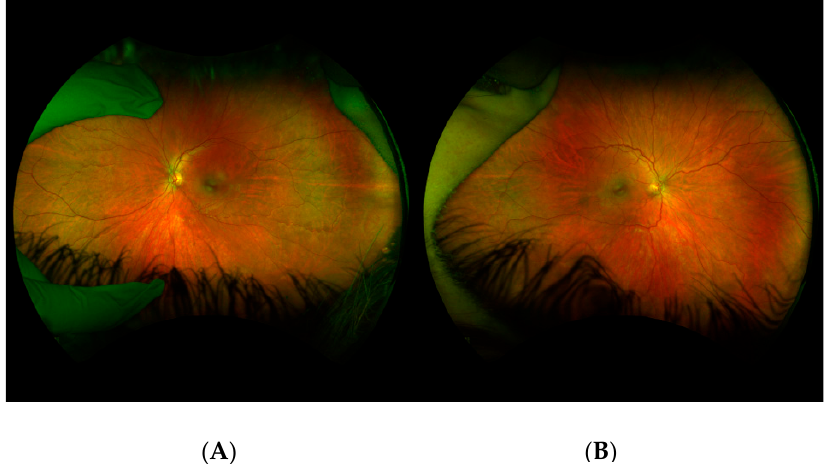
Figure 2. Fundus photos of Patient III-4. Fundus photos of Patient III-4 showing a normal posterior pole in the right eye ( A ) with a small CHRPE at 3:00 in the left eye ( B ).